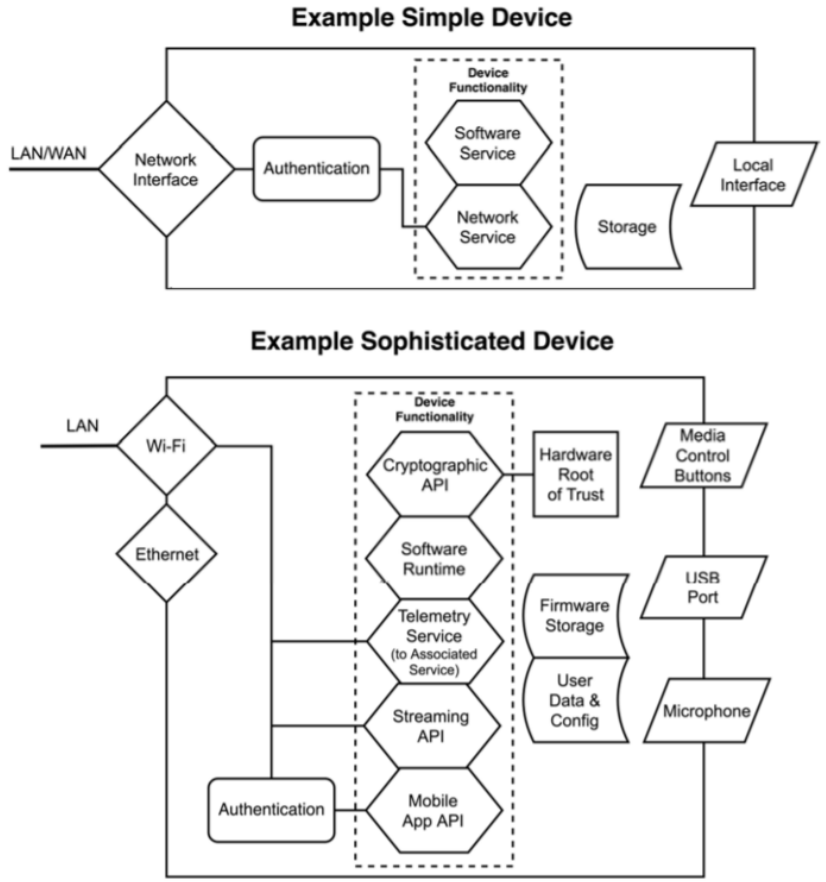
Figure 4. Examples of a general architecture of a device and of an architecture for an IoT device